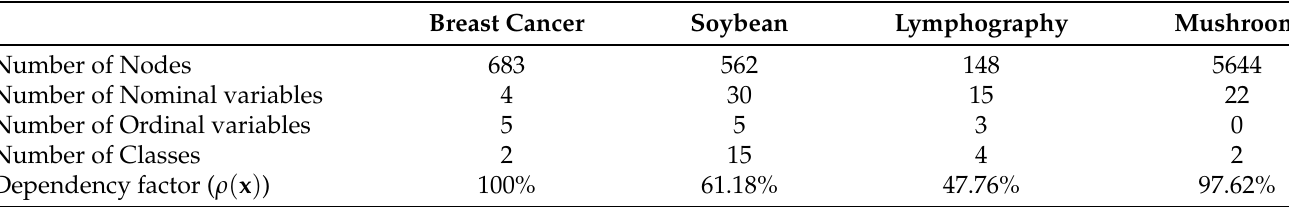
Table 4. Dataset information including the dependency factor. Breast Cancer